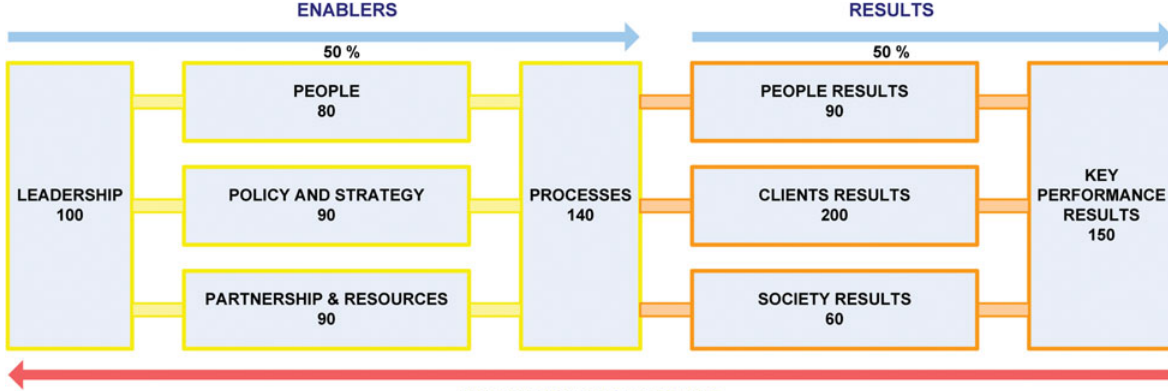
Fig. 2. EFQM Excellence Model (EFQM